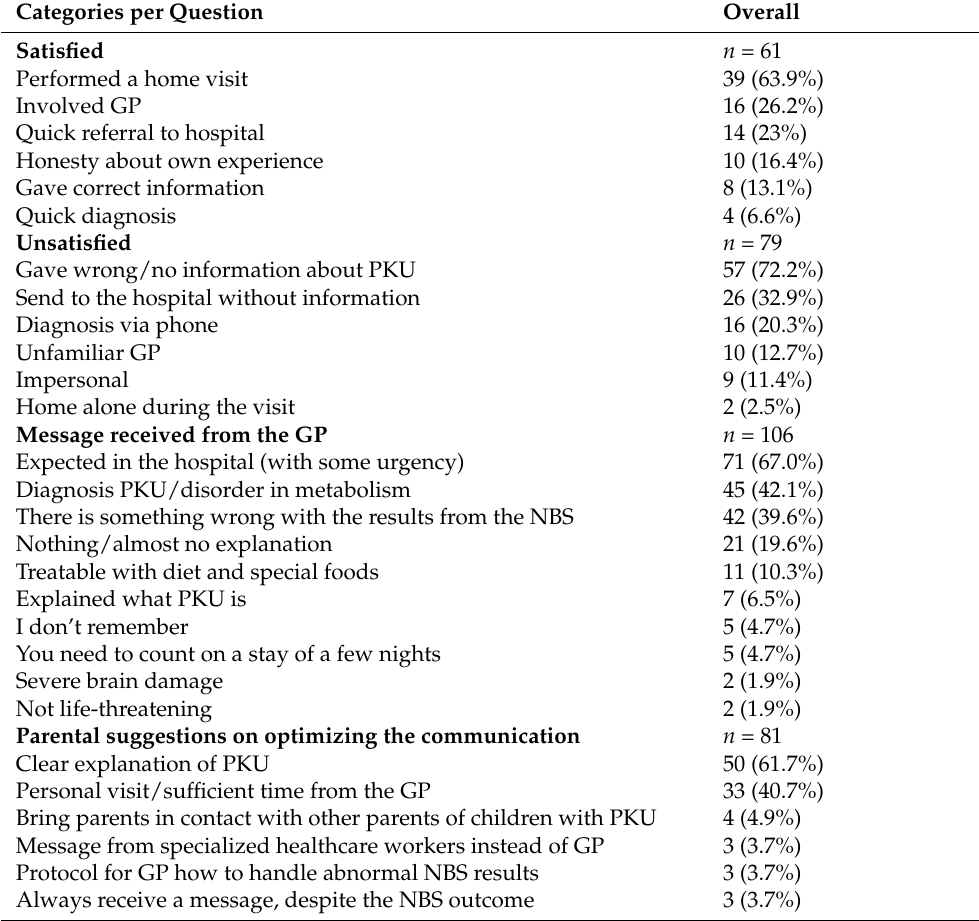
Table 2. Summary of overall results per category per